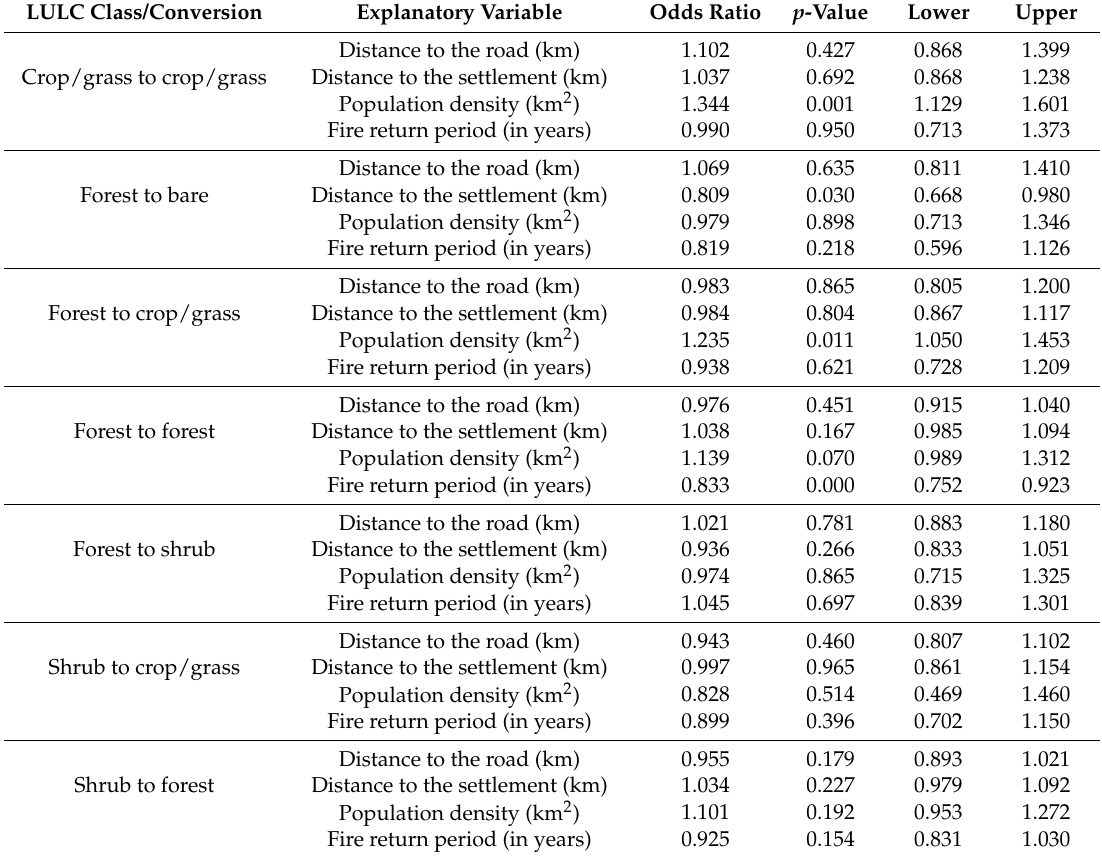
Table 6. Factors affecting the LULC class/conversion in the protected